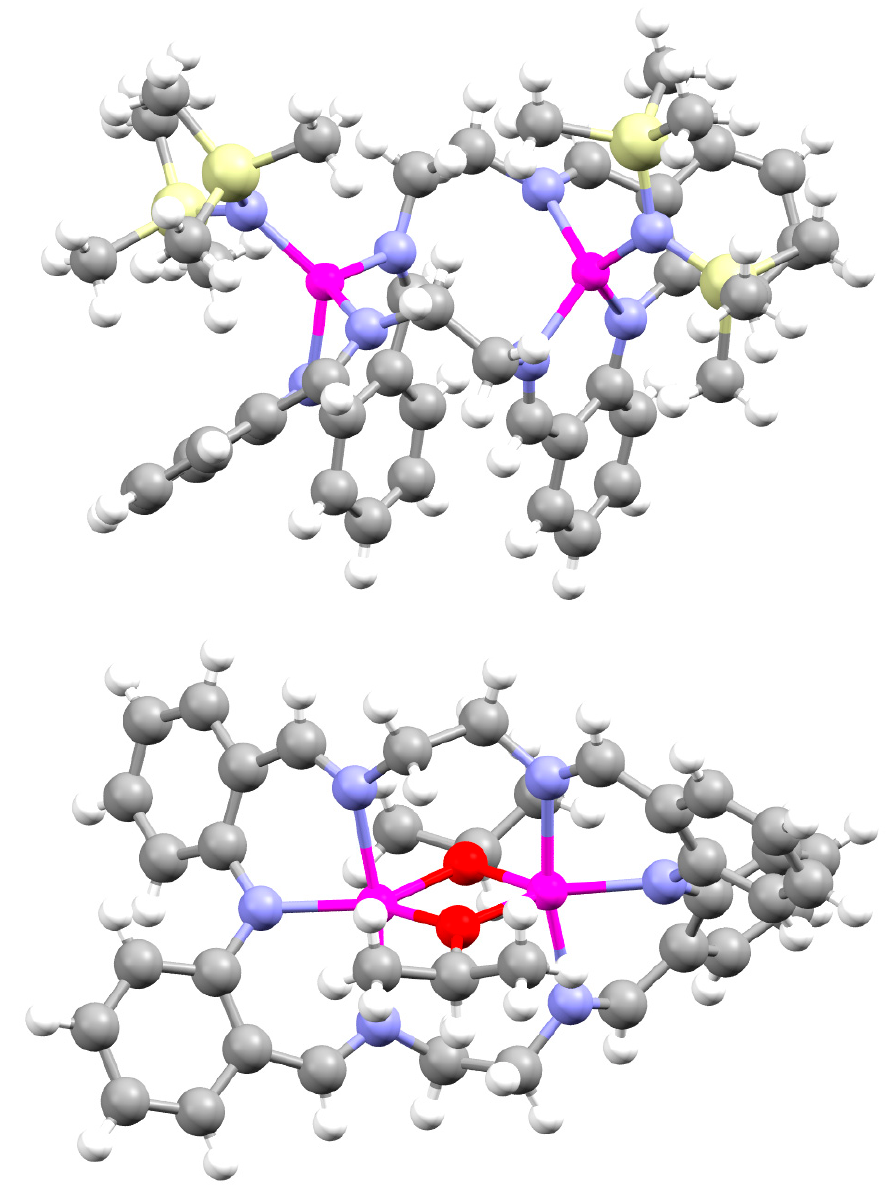
Figure 2. Molecular structures of complexes ( 27 ) ( top ) and ( 30 ) ( bottom ).